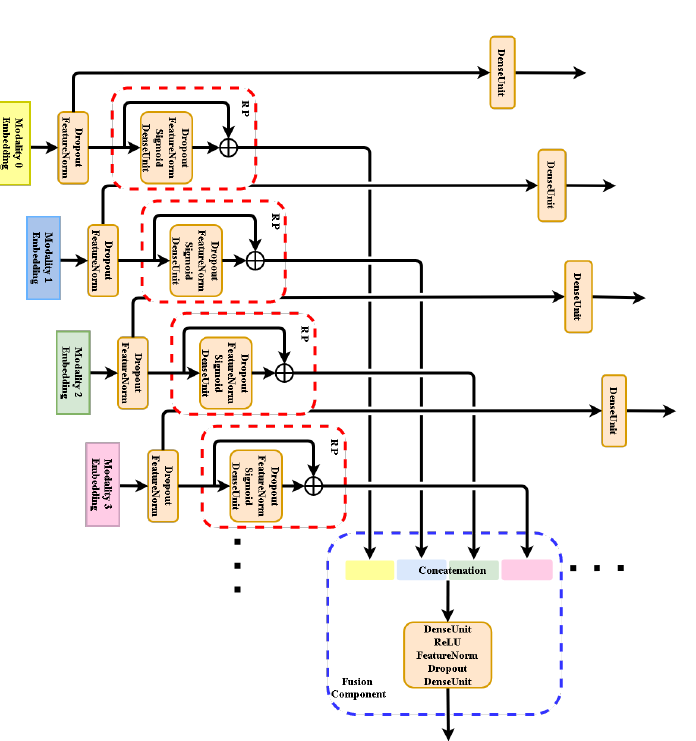
Figure 7. Generalization of our MRPN fusion approach to many modalities. It could be used for either regression or classification